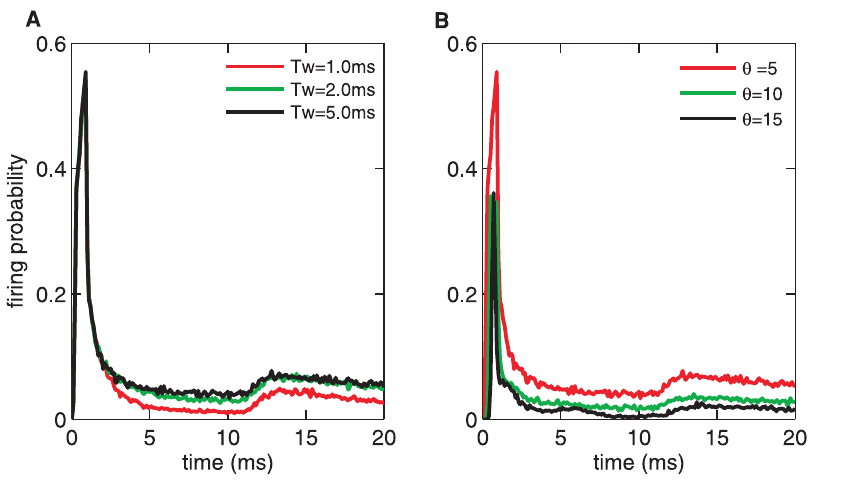
Figure 2. PSTH of the CD neuron. The neuron network responds to a rectangular current for (A) various T w values with fixed h ~ 10 and (B) various thresholds h with the time window T w ~ 1 : 0 ms. In all cases, the input on the LIF neurons in the first layer is below the threshold V th and the embedded noisy current input is Gaussian white noise with a noise intensity D ~ 20 mV/ms. The PSTH is obtained from 5000 trials. Simulation parameters: the LIF neruon threshold, the resting potential and the membrane time constant are V th ~{ 40 mV, V r ~{ 65 mV and t m ~ 10 ms respectively; the number of LIF neuron is N ~ 100 ; the time step 0 : 01 ms.